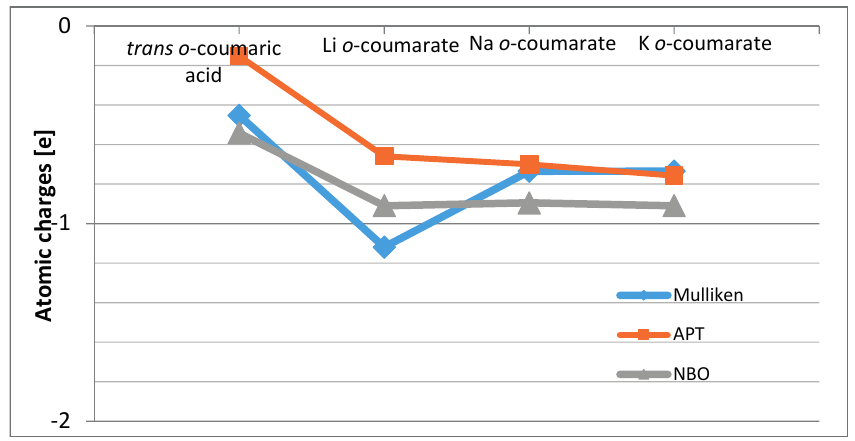
Figure 2. The changes in Mulliken, APT and NBO total charges on carboxylate group in alkali metal o- coumarate molecules in comparison with trans o- coumaric